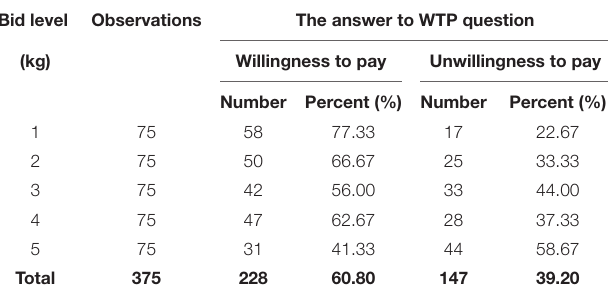
TABLE 2 | Willingness and unwillingness to pay for the given discrete